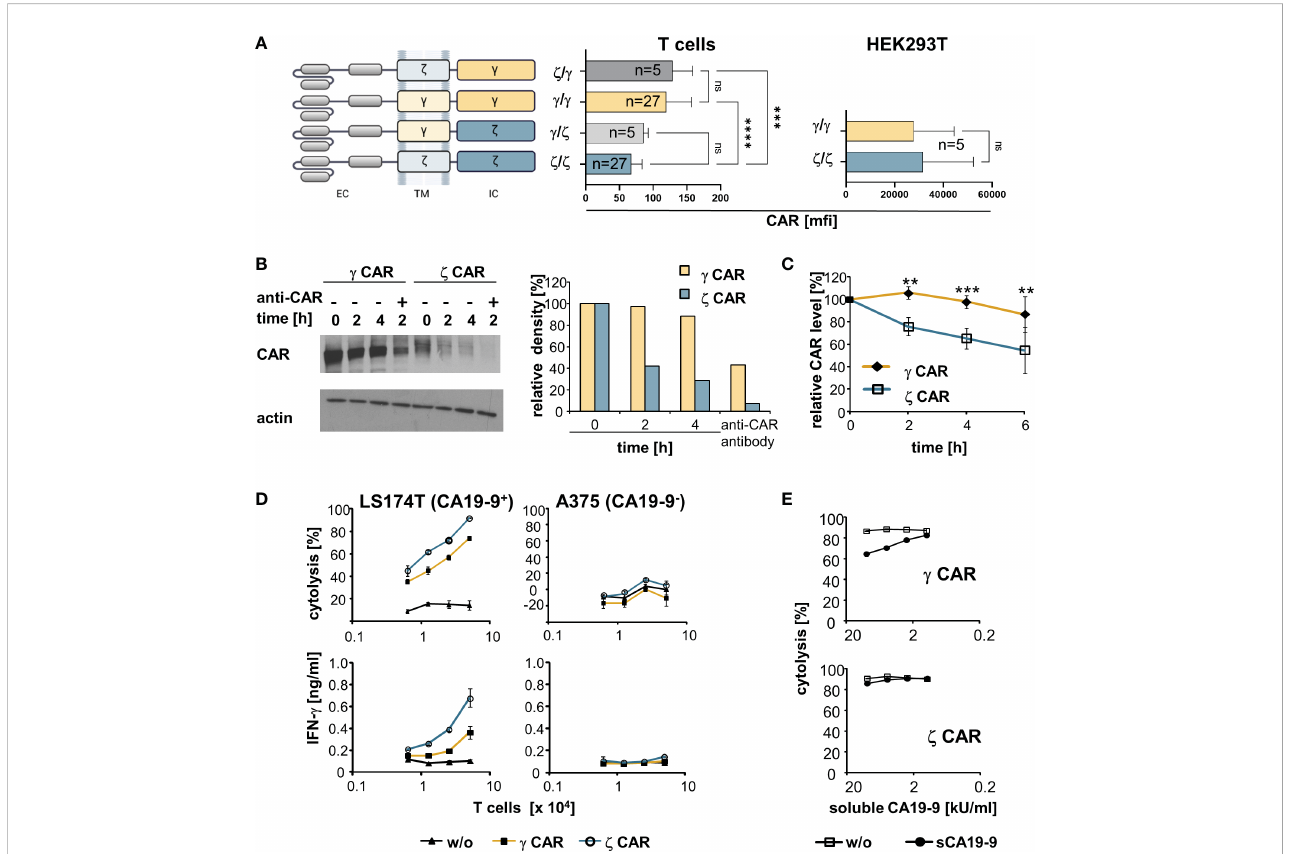
FIGURE 1 CARs with an intracellular CD3 z chain are superior over g − chain CARs in T cell activation despite lower cell surface expression and shorter half-life on the T cell surface. (A) Schematic representation of CARs with their respective transmembrane (TM) and intracellular (IC) signaling domains consisting of the respective CD3 z ( z ) or the Fc e RI g ( g ) chain. All CARs harbour the same extracellular domain (EC) and were expressed by the same promoter in the same retroviral vector backbone. Cells were engineered with the respective CARs. CAR expression was monitored by an anti − IgG Fc antibody that detects the common extracellular CAR IgG1-Fc spacer domain. Background staining was determined by an isotype control antibody. Data represent the mean values of mean fl uorescence intensity (m fi ) ± SD. (B) MD45 cells were engineered with a z or a g CAR, respectively, and incubated with cycloheximide (10 µg/ml) to block protein synthesis. For comparison, the CARs were additionally cross-linked by an anti − IgG (anti − CAR) antibody, that binds to the extracellular CAR spacer domain, for 2 h to induce CAR internalization. At different time points, 10 7 cells were lysed and proteins separated by SDS-PAGE on 8% (w/v) polyacrylamide gels under non-reducing conditions. CARs were detected by the anti − IgG Fc-POD antibody (1:10,000), actin was detected by the anti − actin antibody (0.5 µg/ml). Relative density of CAR bands was quanti fi ed utilizing the ImageJ software 1.48 and presented as percent of the initial amount at t=0. Data from a representative experiment out of three are shown. (C) Pulse-chase CAR labeling. CAR transfected cells were surface-labeled with biotin as described in Materials and Methods, washed and stimulated at 37°C by an anti − IgG antibody (1 µg/ml) directed against the IgG extracellular CAR domain. Aliquots of cells (5 x 10 6 cells) were lysed at different time points and lysates were subjected to ELISA plates coated with an anti − IgG1 mAb (1 µg/ml) to capture the CAR. Bound labeled CARs were detected by streptavidin POD and visualized with ABTS. OD at time point 0 was set at 100% and relative ODs at indicated time points were calculated. Numbers represent the mean values of three independent experiments ± SD. (D) CAR redirected T cell activation. T cells with z - or g − chain anti − CA19 − 9 CAR were expanded in the presence of IL − 2 and co- cultivated (0.625 – 5 x 10 4 cells/well) for 48 h with CA19 − 9 + LS174T or CA19 − 9 - A375 tumor cells (5 x 10 4 cells/well). Supernatants were analyzed for IFN − g by ELISA, target cell lysis was determined by the XTT assay. Data represent mean values ± SD of two independent experiments. w/o, without CAR. (E) Activation of CAR T cells in the presence of soluble CA19 − 9 antigen. Anti − CA19 − 9 CAR T cells (5 x 10 4 cells/well) were co-cultivated for 48 h with CA19 − 9 + LS174T cells (5 x 10 4 cells/well) in the presence of serial dilutions of supernatants of H498 tumor cells containing about 20,000 U/ml of soluble CA19 − 9 (sCA19 − 9). Target cell lysis was determined by the XTT assay. For control, cells were co-cultivated in the presence of supernatants of the CA19 − 9 - cell line H716 lacking soluble CA19 − 9 (w/o). Data represent mean values ± SD of technical triplicates. For comparison of two groups, signi fi cant differences were determined by Student´s T test. For comparisons of three or more groups, one-way ANOVA with Tukey ’ s post hoc test was used. p-values < 0.05 were considered statistically signi fi cant (**p<0.01; ***p<0.001; ****p<0.0001; ns, not signi fi